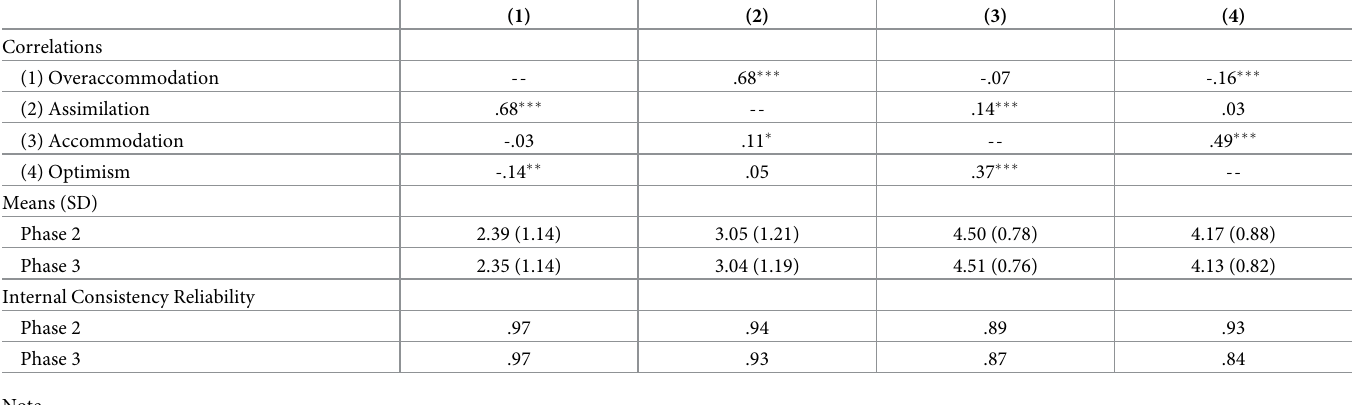
Table 3. Descriptive statistics, inter-scale correlations, and internal consistency reliability estimates of the TRCS subscales in the Phase 2 ( N = 815) and Phase 3 ( n = 651) non-clinical